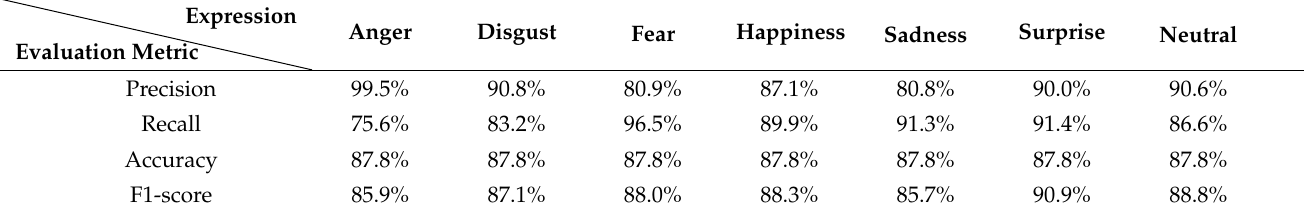
Table 4. Evaluation data of human facial expression